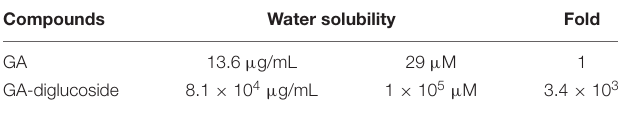
TABLE 3 | Solubility of GA and GA-diglucoside in